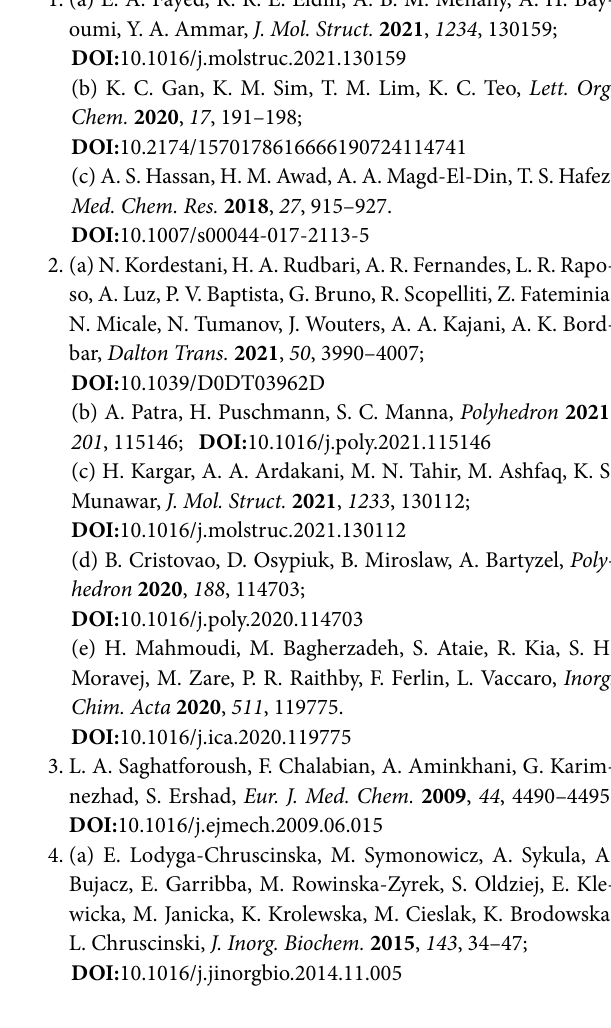
Table 3. MICs (μg mL –1 ) of the compounds and related materials Tested material Gram positive